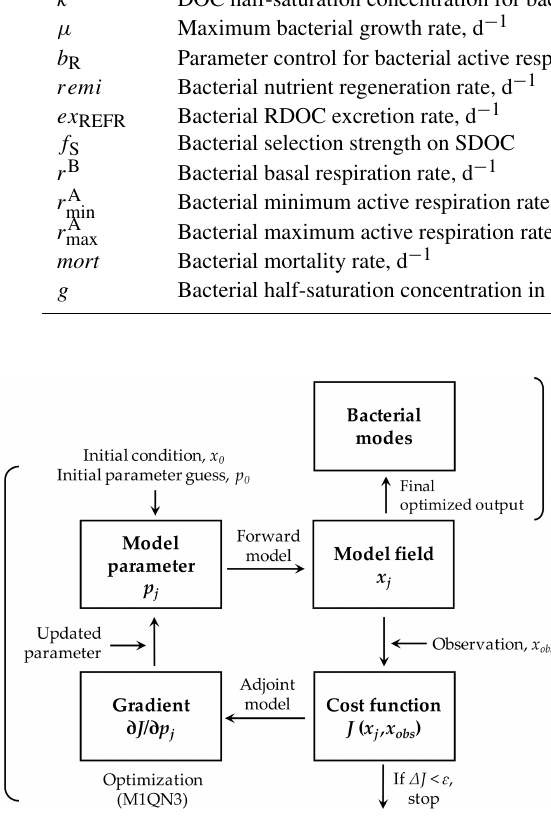
Figure 2. Modeling framework. The modeling framework in this study consists of the mechanistic part as the processes associated with the bacteria-oriented ecosystem model (Fig. 1) and the data- driven part that represents how bacterial taxonomic modes are as- sociated with the modeled bacterial and other key ecosystem func- tions. A variational adjoint method is employed for the parameter optimization and data assimilation processes (adapted from Glover et al., 2011). Gradient: the sensitivity of the total cost function with respect to the model parameter from optimization. Optimized model results are interpreted as a function of bacterial taxonomic and phys- iological